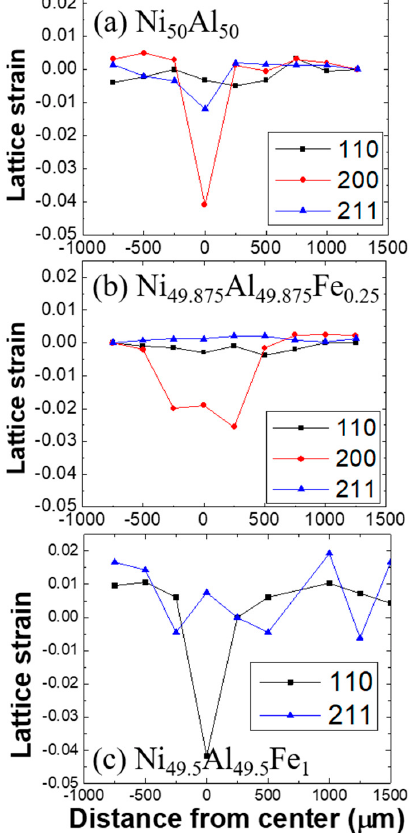
Figure 2. Lattice-strain distributions of (110) as squares ( ■ ), (200) as circles ( ● ), and (211) as triangles ( ▲ ), respectively, around indented centers for ( a ) Ni 50 Al 50 ; ( b ) Ni 49.875 Al 49.875 Fe 0.25 ; and ( c ) Ni 49.5 Al 49.5 Fe 1